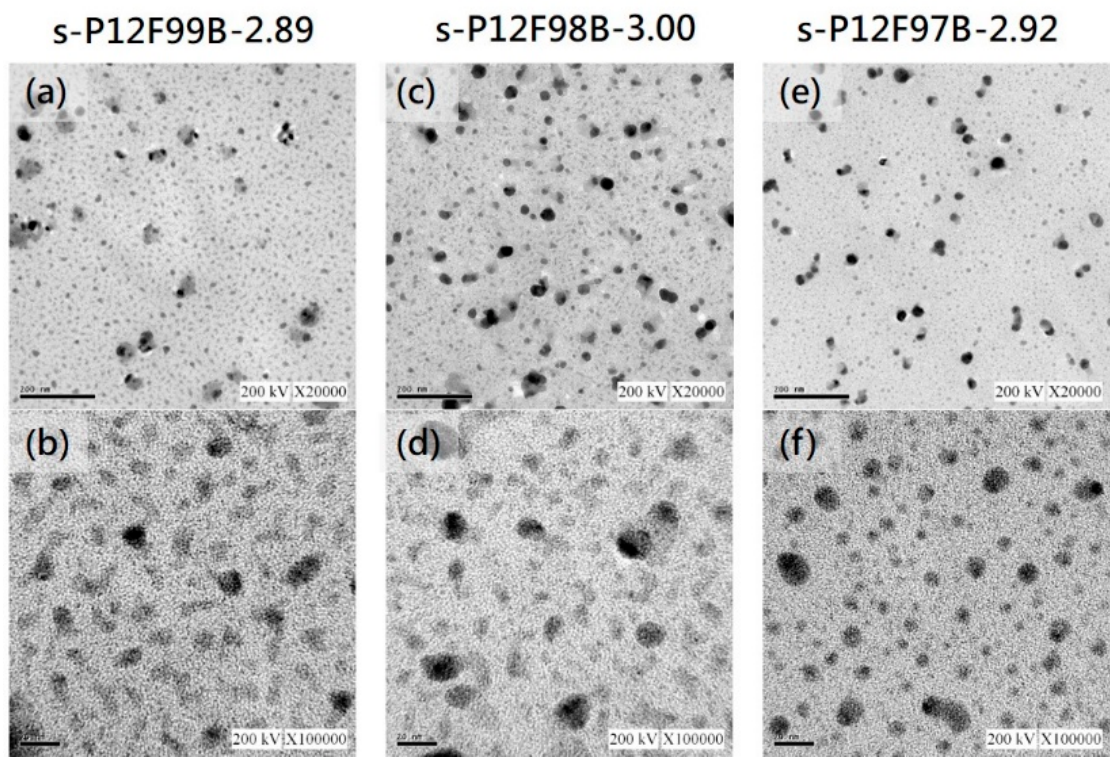
Figure 7. TEM image of the ( a ) s-P12F99B-2.89 membrane at 20k and ( b ) 100k magnification; ( c ) s-P12F98B-3.00 membrane at 20k and ( d ) 100k magnification; ( e ) s-P12F97B-2.92 membrane at 20k and ( f ) 100k